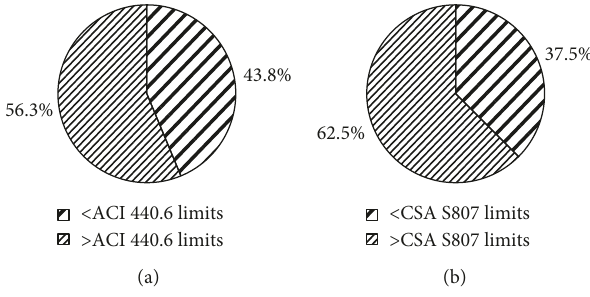
Figure 9: Percentage of GFRPs within acceptable durability limits. (a) ACI 440.6. (b) CSA S807.